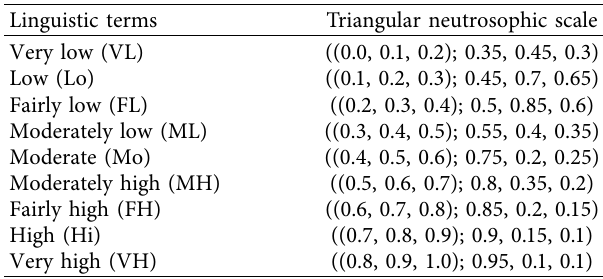
Table 1: Linguistic to triangular SVNFN conversion scale (adapted from Abdel–Basset et al.